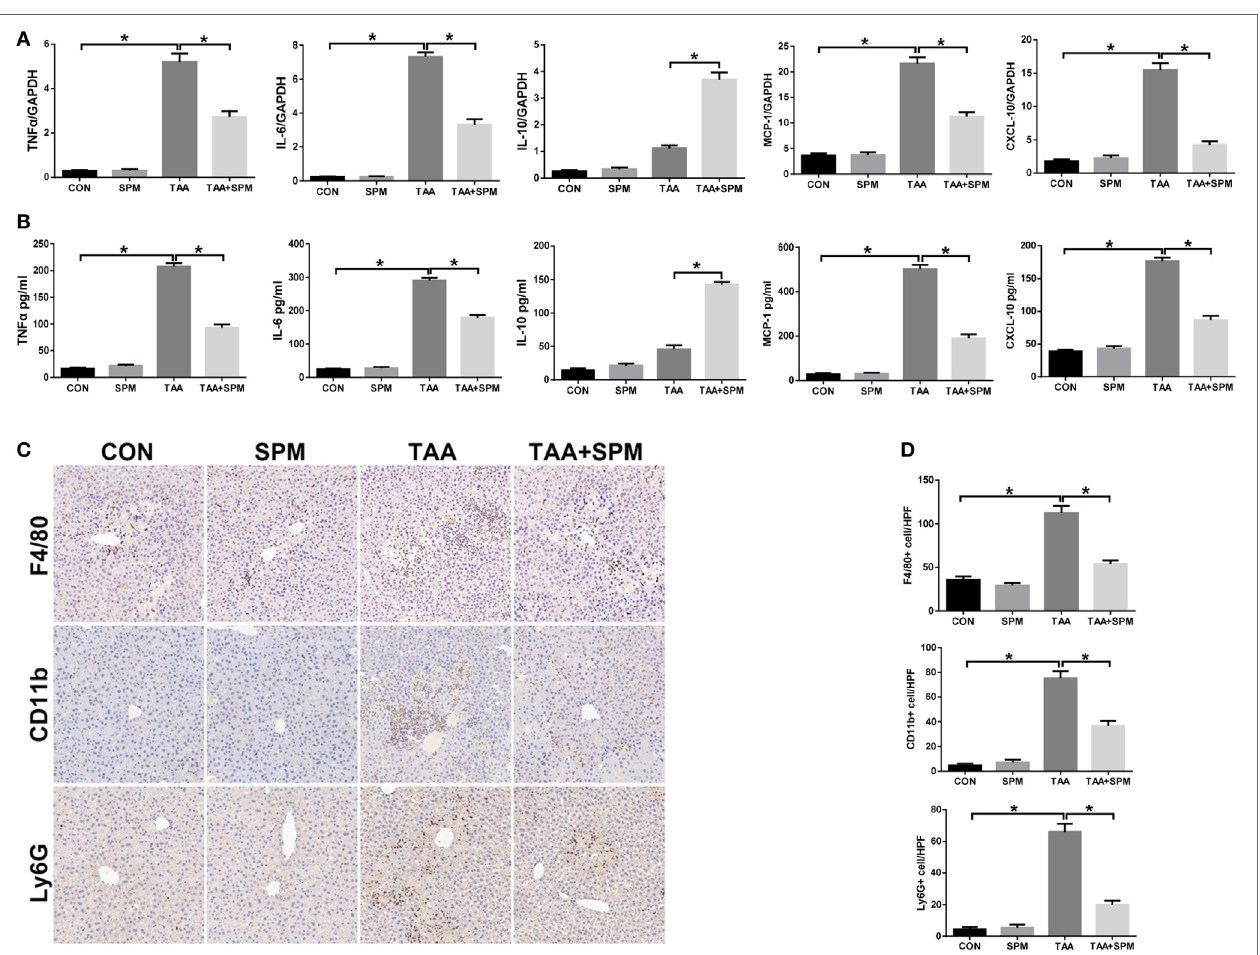
FigUre 2 | Spermine (SPM) pretreatment reduces innate immune and inflammatory responses in thioacetamide (TAA)-treated livers. Mice were subjected to SPM pretreatment and TAA administration as described in Section “Materials and Methods.” Inflammatory gene expression was measured in liver tissue by quantitative RT-PCR [ (a) , n = 6/group]. Serum levels of inflammatory cytokines were measured by ELISA [ (B) , n = 6/group]. F4/80 + macrophages, CD11b + macrophages, and Ly6G + neutrophils infiltration in liver was detected by immunohistochemical staining [ (c) , n = 6/group]. Quantification of F4/80 + macrophages, CD11b + macrophages, and Ly6G + neutrophils per high power field (original magnification 20 × ). Representative of six mice/group (D) (* p <